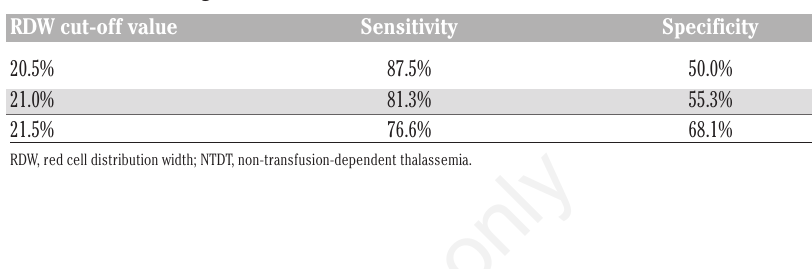
Table 2. RDW cut-off values and their sensitivity and specificity in the diagnosis of NTDT in the training set.